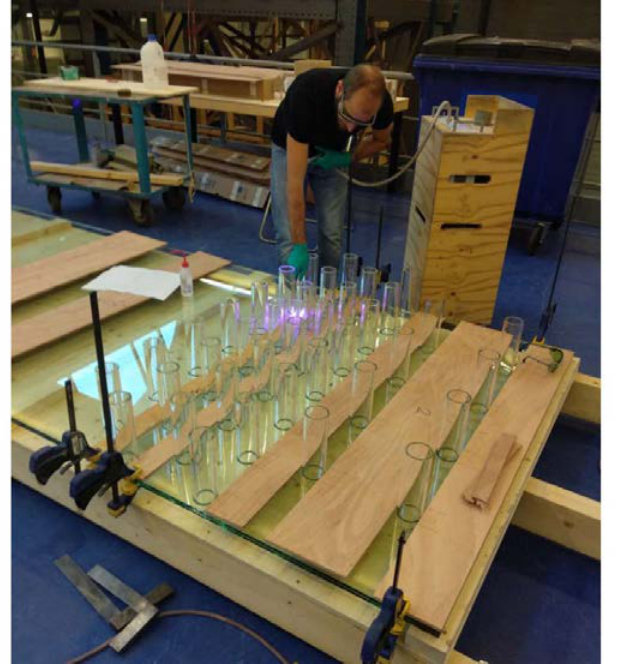
Fig. 10 production of bottom part of sandwich panel.